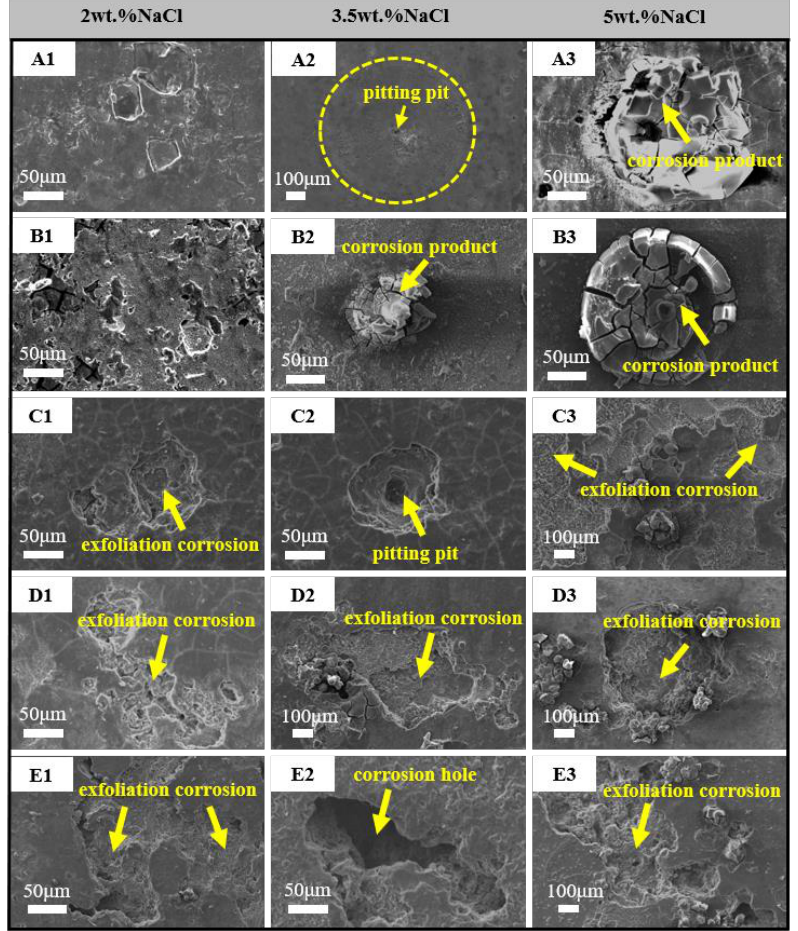
Figure 11. The microscopic morphology of specimens immersed in different concentrations of NaCl solution for 28 days ( A : 2A97-T3; B : 2A97-T6; C : 2024-T4; D : 2060-T8; E : 2099-T83).